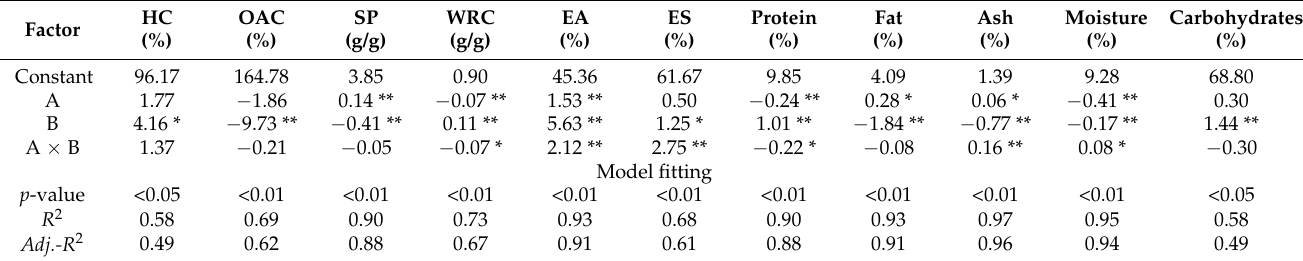
Table 3. ANOVA results for the 2 FI model fitted for the functional properties of sorghum